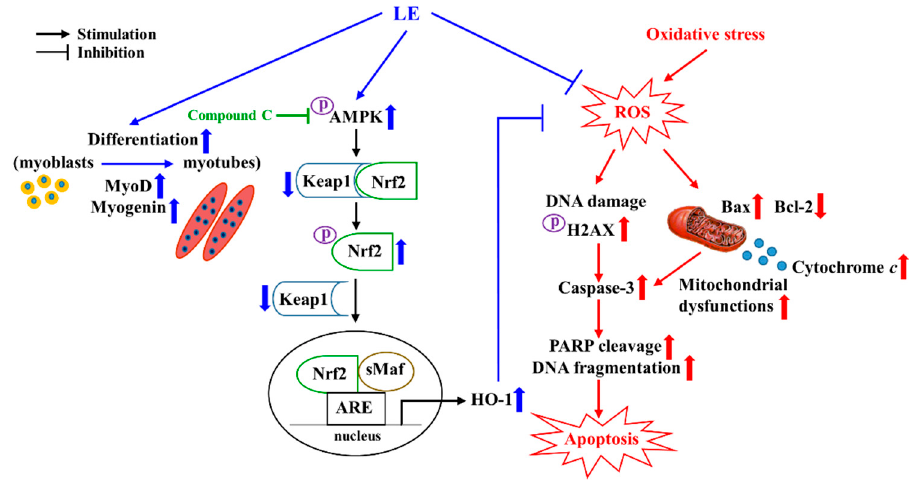
Figure 11. Schematic pathway of the effects of LE on oxidative stress-mediated DNA damage, apoptosis, and cell differentiation. AMPK, 5 ′ adenosine monophosphate-activated protein kinase; ARE, antioxidant response elements; Bax, Bcl-2 associated X protein; Bcl-2, B-cell lymphoma-2; Compound C, AMPK inhibitor; HO-1, heme oxygenase-1; H2AX, H2A histone family member X; Keap1, Kelch-like ECH-associated protein 1; MyoD, myogenic differentiation 1; Nrf2, nuclear factor erythroid 2-related factor 2; PARP, poly(ADP-ribose) polymerase; sMaf, small Maf.